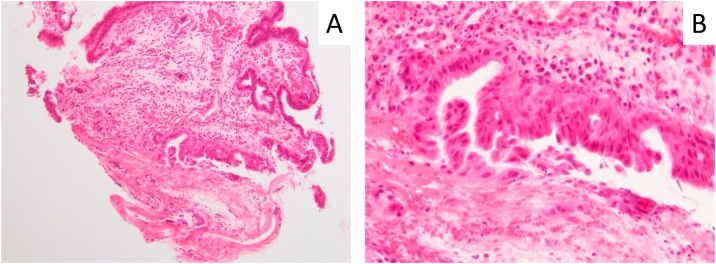
Histopathological findings of biopsy specimen consistent with well differentiated adenocarcinoma (hematoxylin-eosin staining). A: low magnification; B: high magnification.